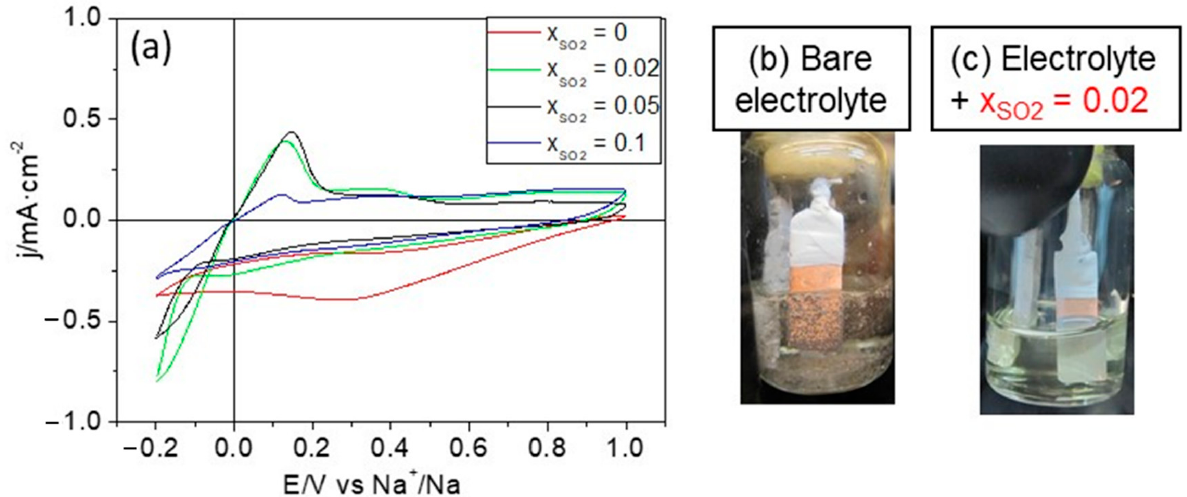
Figure 2. ( a ) CVs for the deposition of Na on Cu in 2 M or 1.6 M (in the presence of SO 2 ) NaTf/DOL:DME at 20 mV · s − 1 for different mole fractions of SO 2 . Pictures showing the sodium deposit morphology on Cu before ( b ) and after ( c ) adding a SO 2 mole fraction of 0.02. Pictures ( b , c ) were obtained after applying a potential of − 0.2 V vs. Na + /Na for 500 s.